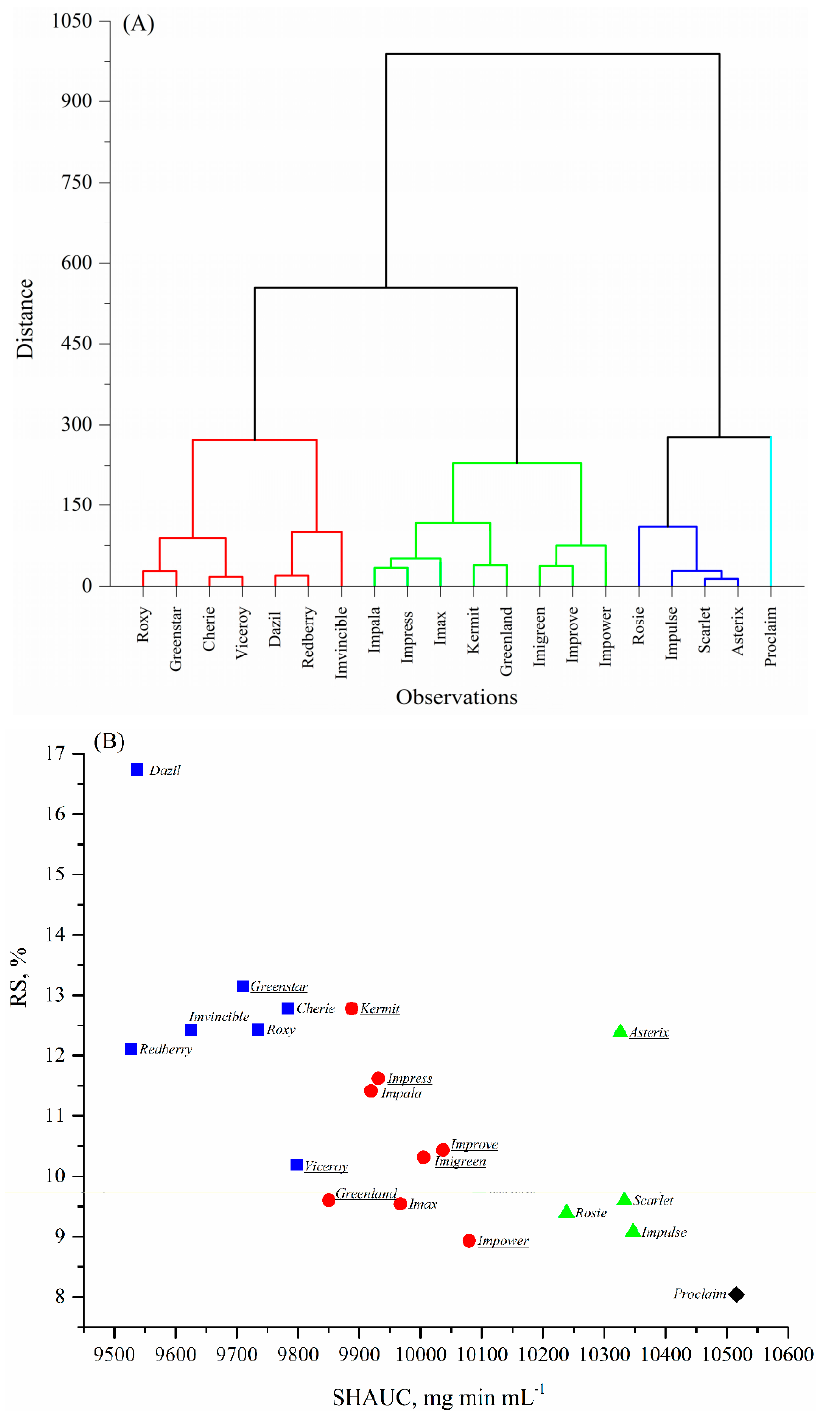
Figure 2. Cluster analysis of the 20 lentil varieties and four plotted groups corresponding to the area under the in vitro starch hydrolysis curve (SHAUC) and RS value. ( A ) Dendrogram by Hierarchical cluster analysis; ( B ) K -means plot corresponding to the SHAUC and RS values. Symbols in Figure 2B, ■ , cluster 1; ● , cluster 2; ▲ , cluster 3; and ♦ , cluster 4. Green lentil names were underlined.